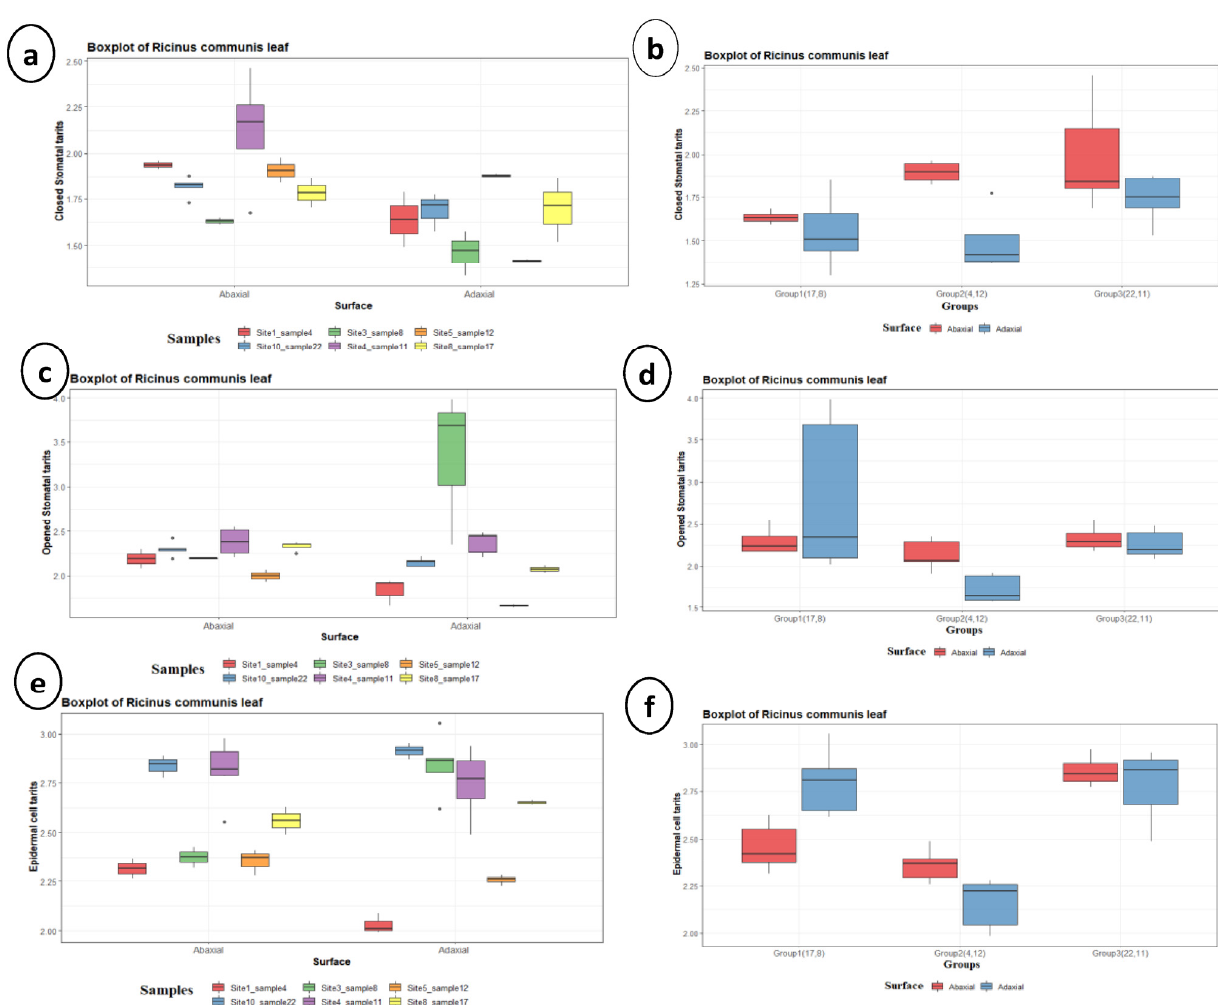
Figure 6. Boxplots of the leaf ultrastructure traits of Ricinus communis for all samples and for groups, respectively. ( a , b ) closed stomatal traits, ( c , d ) opened stomata, ( e , f ) epidermal cell size traits. For the AD surface, showing a significant difference between all samples, the sto- matal size with the closed pore was 5.82–13.17 × 2.66–6.30 µm, and its area varied from 10.24 to 56.13 µm 2 (Figure 6a), while the stomatal size with an opened pore was 6.76– 132.49 × 3.38–65.73 µm with a pore size is 4.13–116.03 × 1.13–33.07 µm. The stomatal and pore areas were in the range of 16.95–6780.36 µm 2 and 3.30–2403.10 µm 2 , respectively (Fig- ure 6c). The epidermal cell length was 26.36 ± 9.19 µm, the width was 16.04 ± 6.00 µm, and the area was 451.23 ± 287.98 µm 2 (Figure 6e).